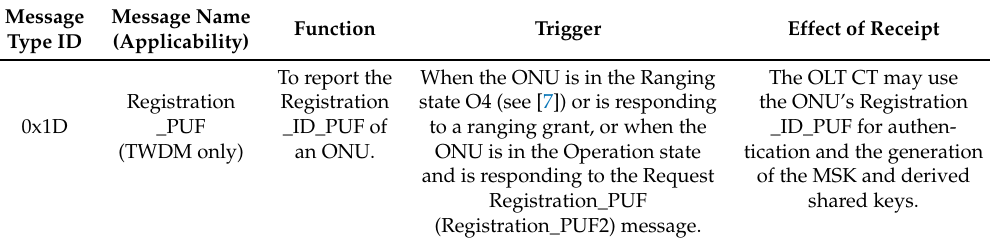
Table 3. New upstream PLOAM message.